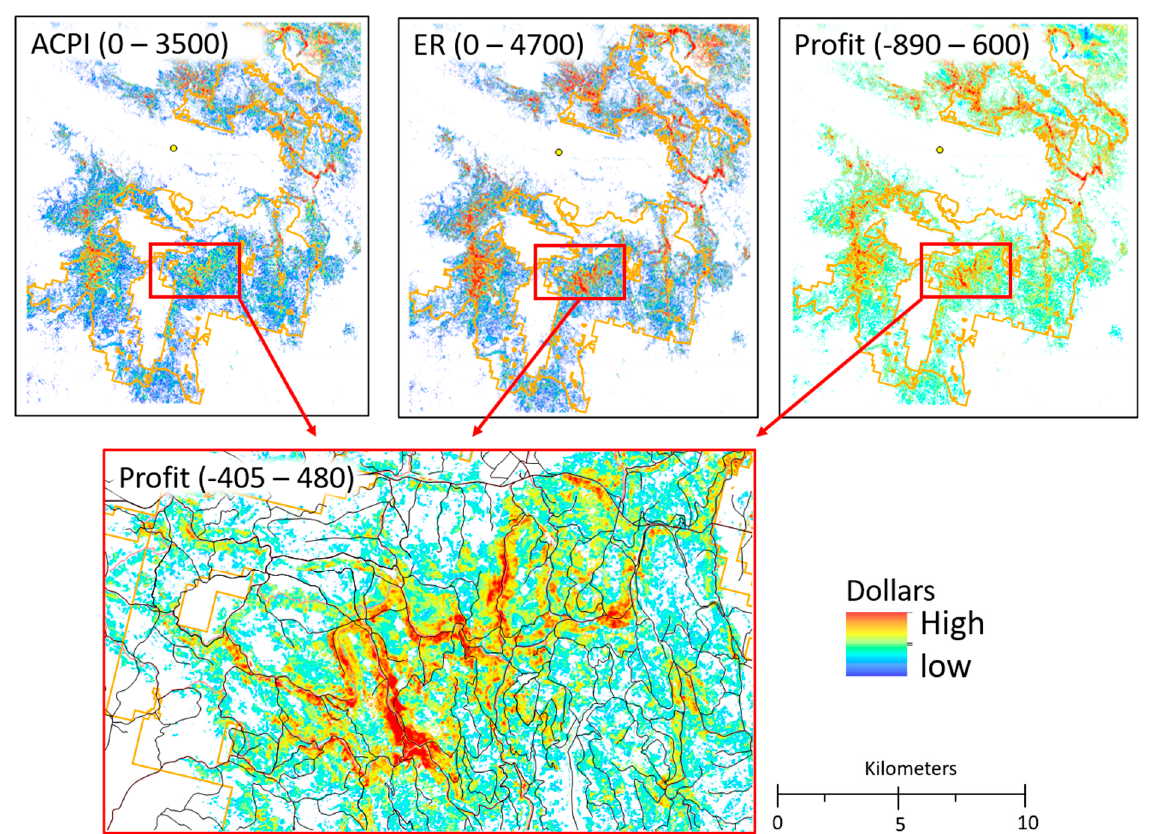
Figure 10. An illustration of anticipated cost of implementation (ACPI), total expected revenue (ER), and profit margins (Profit) raster surfaces. The range of dollar values for each graphic is displayed within the parentheses of the graphic title. Malheur Lumber Company (yellow point), linear road network (black lines), and the collaborative forest landscape restoration program polygons (orange polygons) are displayed for reference in the various graphics. The red bounding box within the top graphics and around the bottom graphic provides a zoomed-in representation of the profit margins.